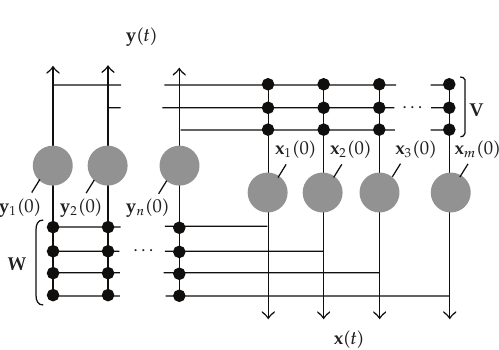
Figure 11: Architecture illustration of the bidirectional associative